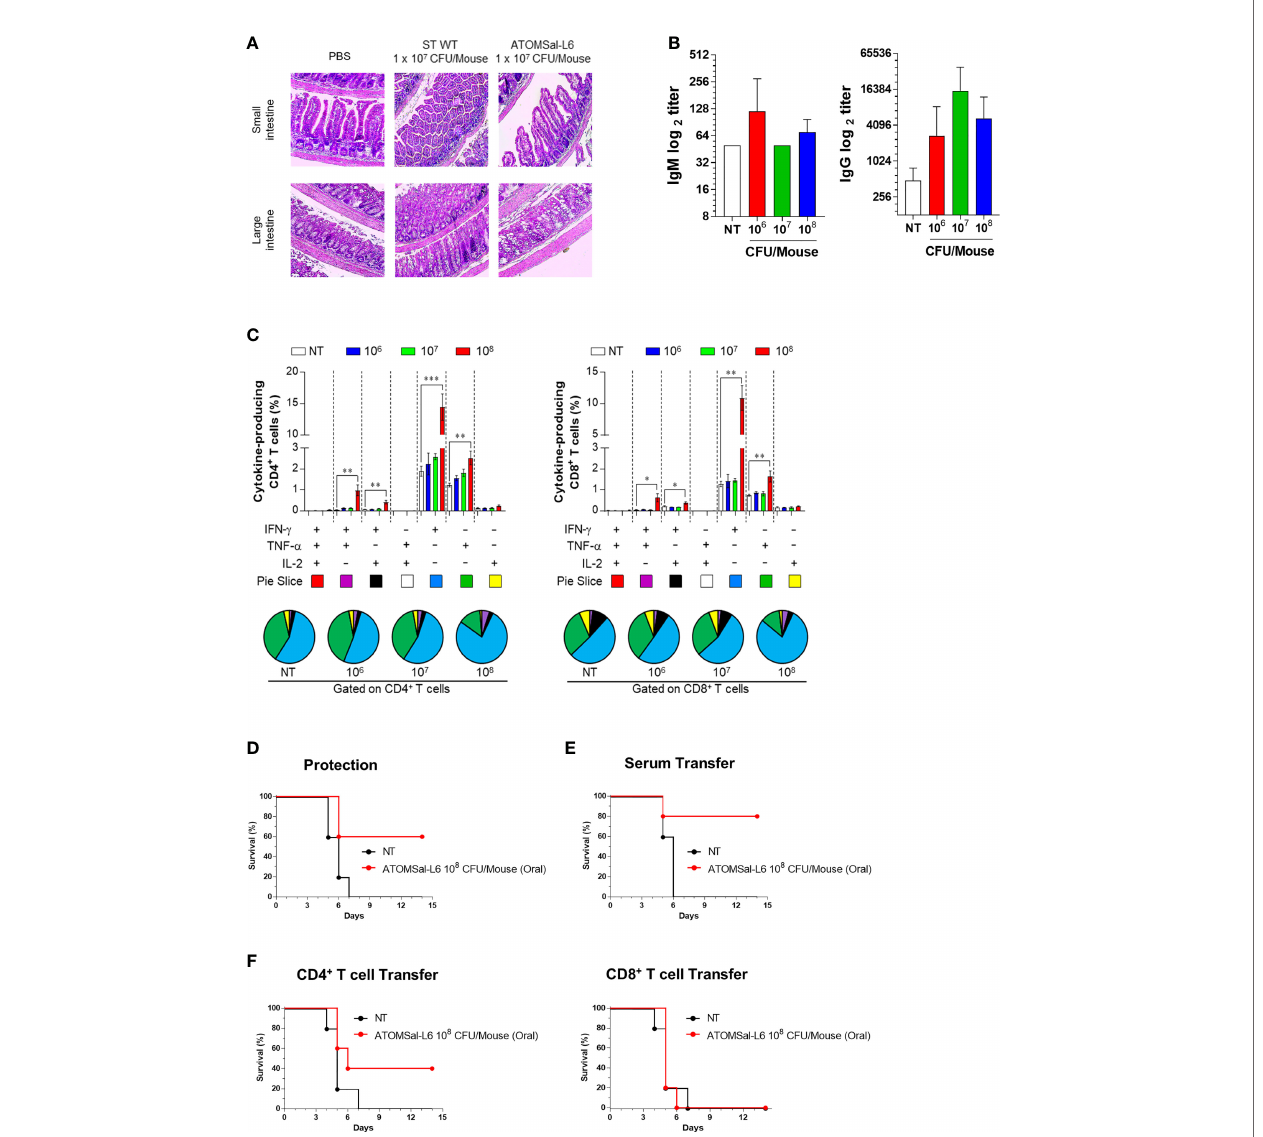
FIGURE 5 | Analysis of humoral and cellular immune responses induced by oral immunization of ATOMSal-L6. (A) Safety of ATOMSal-L6 vaccine. Mice were inoculated orally with 10 7 CFU of ST WT or ATOMSal-L6. At 3 d.p.i, mice were sacri fi ced, and small or large intestinal tissue were stained with H&E. (B) Humoral immune response. Mice (n = 5 per group) were orally immunized with 10 6 , 10 7 , or 10 8 CFU of ATOMSal-L6 thrice at two-week intervals and sera were collected two weeks after the last vaccination. ST-speci fi c IgM (left panel) and IgG (right panel) were measured using ELISA. (C) Cellular immune response. Single cell suspensions of spleen were re-stimulated with 10 m g/mL ST WT lysate for 12 h and ST-speci fi c multifunctional CD4 + and CD8 + T cells were analyzed. The percentage of ST- speci fi c total cytokine (IFN- g , TNF- a , and/or IL-2)-producing cells among splenic CD4 + CD44 + memory T cells (left panel) or CD8 + CD44 + memory T cells (right panel). Pie charts (bottom panel) representing the mean frequencies of cells co-expressing IFN- g , TNF- a , and/or IL-2. The relative amounts of single-, double-, and triple- functional memory T cells are indicated as pie arcs. Means ± SD (n = 5 mice/group) shown are representative of two independent experiments. *P < 0.05, **P < 0.01, ***P < 0.001, compared to unvaccinated mice. (D) Protective immune response. Mice (n=5) were immunized orally with ATOMSal-L6 (1 × 10 8 CFU) and challenged i.p. with 5 × 10 5 CFU of ST WT strain and survival was monitored for 14 days. (E, F) Protection by the adopted transfer of oral ATOMSal-L6-vaccinated mice serum (E) and CD4 + or CD8 + T cells (F) against Salmonella infection. Mice were immunized orally with ATOMSal-L6 twice at 14-day intervals. Serum (100 m L) or splenic CD4 + (5 × 10 6 cells) or CD8 + T cells (5 × 10 5 cells) from NT or ATOMSal-L6-immunized mice were transferred i.p. into naïve C57BL/6 mice (n=5). At 12 h following inoculation, mice were challenged intraperitoneally with 5 × 10 5 CFU ST WT strain. Mouse survival was monitored for 14